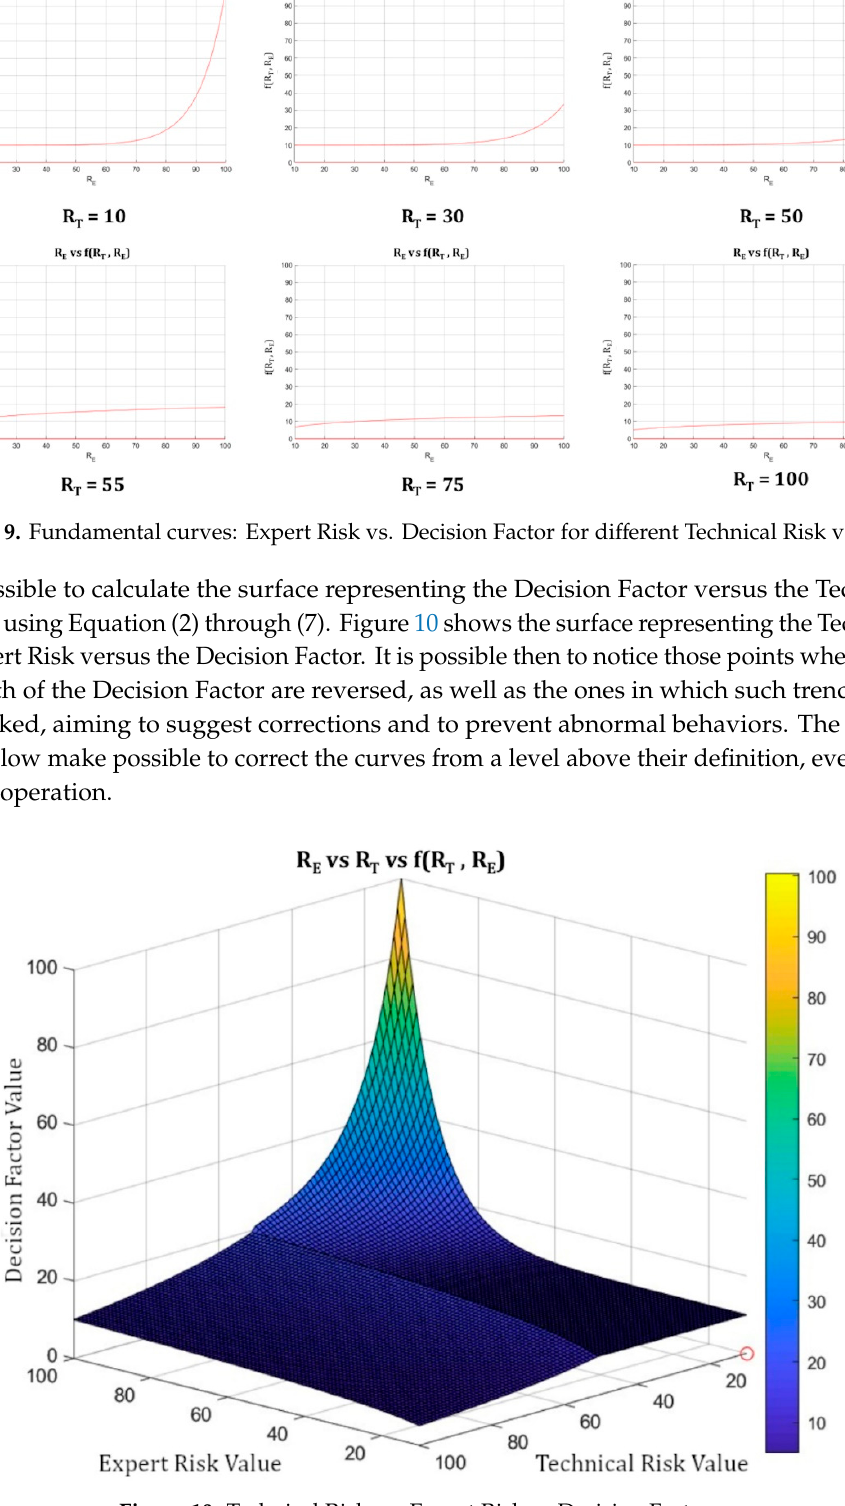
Figure 10. Technical Risk vs. Expert Risk vs Decision Factor.